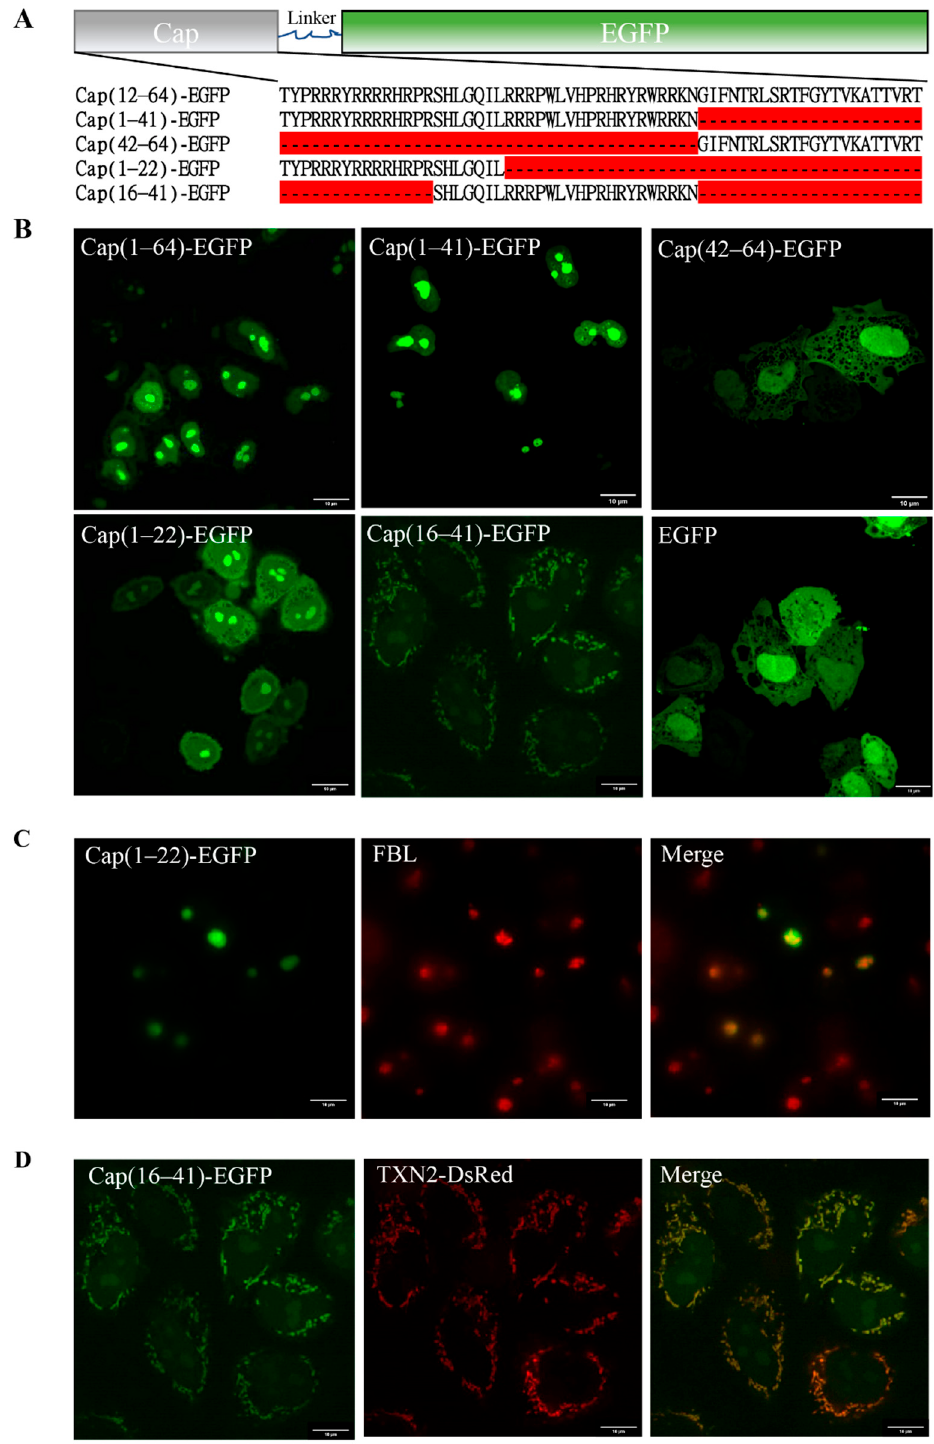
Figure 2. Subcellular localization of PCV2 Cap and mutations. ( A ) The sequence information of recombinant protein Cap-EGFP and mutations. ( B ) Confocal images of the over-expressed Cap(1–64)-EGFP, Cap(1–41)-EGFP, Cap(42–64)-EGFP, Cap(1–22)-EGFP, Cap(16–41)-EGFP and EGFP in PK15 cells. EGFP signal was indicated in green in PK15 cells. Scale bar: 10 µ m. ( C ) Co-localization of Cap(1–22)-EGFP (green) and FBL (red) in PK15 cells. ( D ) Co-localization of Cap(16–41)-EGFP (green) and TXN2-DsRed (red) in PK15 cells.